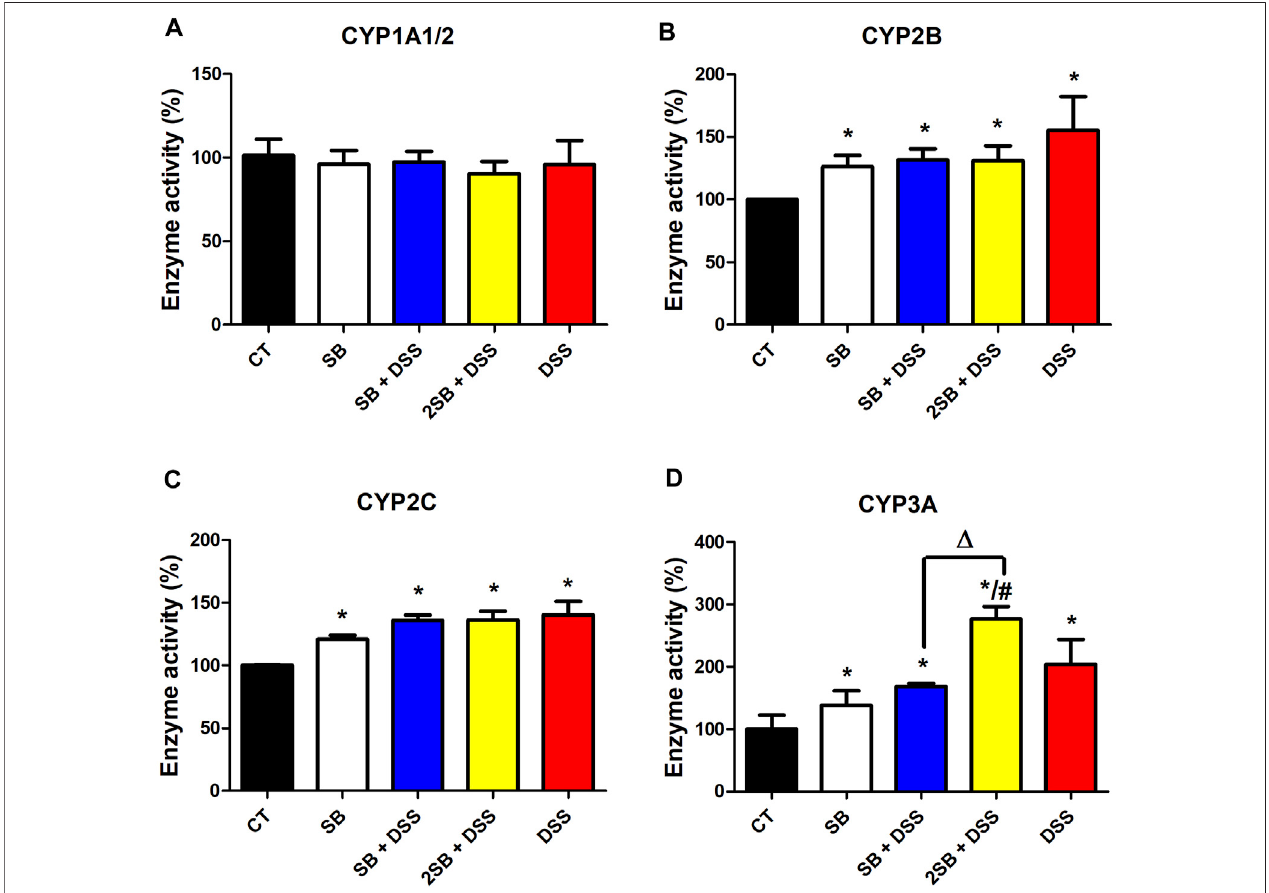
FIGURE 5 | Enzyme activity of selected hepatic cytochromes P450. Enzyme activities of cytochromes P450 (A) CYP1A1/2, (B) CYP2B, (C) CYP2C, and (D) CYP3Aweremeasured inthemouse hepatic microsomal fractions usingthe HPLCsystemwithUV or fl uorescence detection. Datarepresent the mean±SD from three separatedassaysmeasuredinpooledmicrosomalsamplesof fi vemicefromeachgroup.One-wayANOVAwithTukey ’ smultiple posthoc testwasusedforcomparison ofexperimental groupsto controls; *signi fi canceto CT(* p < .05), #signi fi cance toDSS (# p < .05), and Δ signi fi cance ofgroup3to group4 ( Δ p < .05). CT : drinking waterfor1week; SB :0.5%sodiumbutyrateindrinkingwaterfor2weeks; SB+DSS :0.5%sodiumbutyrateindrinkingwater1weekbeforeandthenextweektogether with2.5%DSSindrinkingwater; 2SB+DSS: 0.5%sodiumbutyrateindrinkingwater2 weeksbeforeandthenextweektogetherwith2.5%DSSindrinkingwater; DSS: 1 week 2.5% DSS in drinking